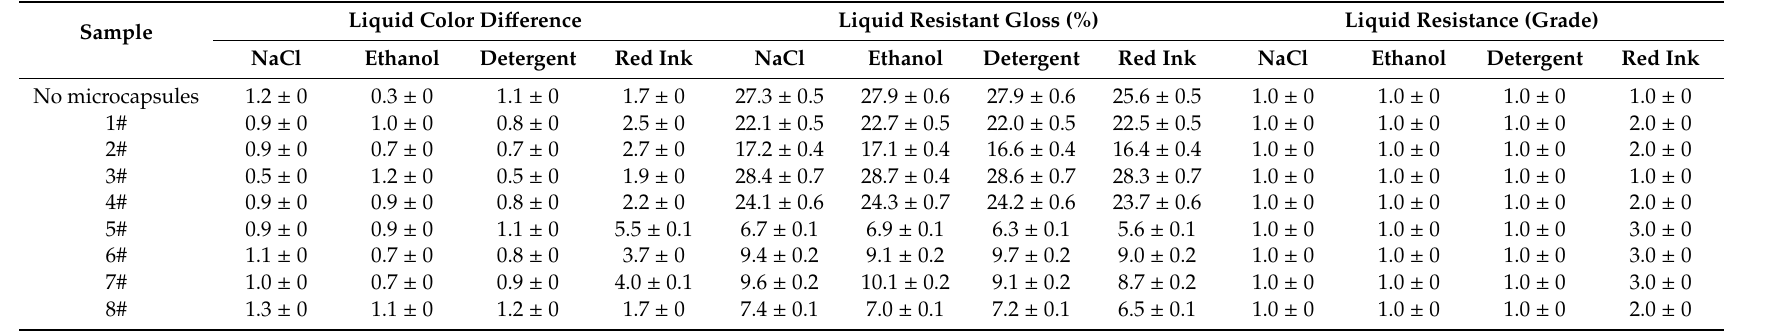
Table 6. E ff ect of coating process on liquid resistance of the paint film with